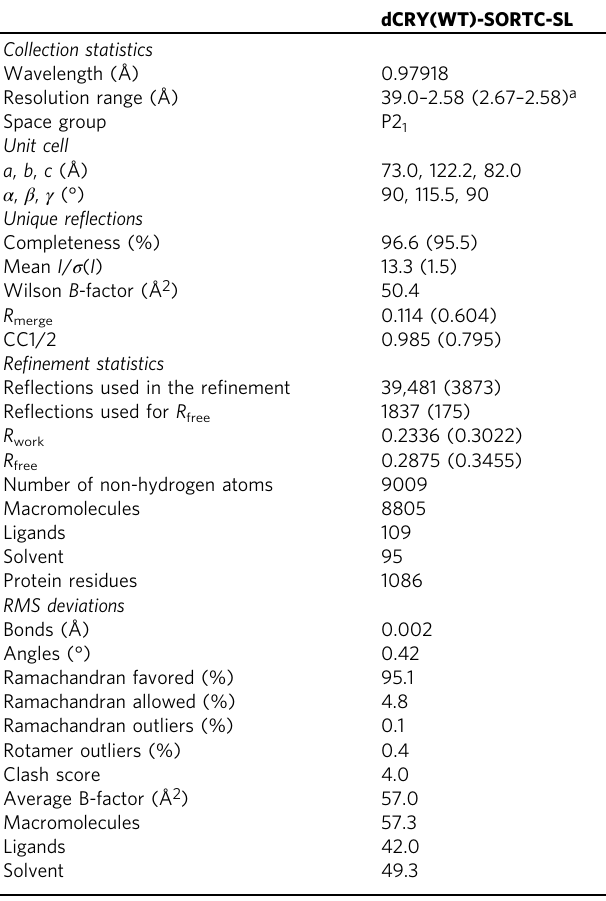
Table 2 Data collection and re fi nement statistics for dCRY